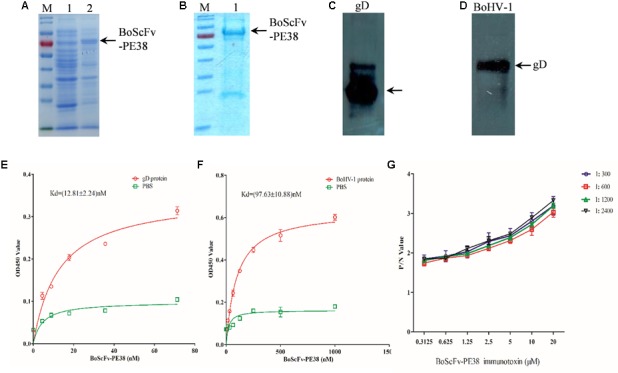
Expression and binding analysis of BoScFv-PE38. (A) Expression of BoScFv-PE38 in E. coli. M: PageRuler Prestained Protein Ladder; 1: the pET28a vector was transformed into E. coli cells, and expression was induced with IPTG; 2: the pET28a- BoScFv-PE38 vector was transformed into E. coli cells, and expression was induced with IPTG. The arrow represents the recombinant ScFv. (B) Purification of BoScFv-PE38 from E. coli via nickel affinity chromatography. M: PageRuler Prestained Protein Ladder. 1 indicates purified BoScFv-PE38, and the arrow represents purified ScFv. (C) The reaction between gD and BoScFv-PE38 was detected by western blotting. Recombinant gD protein detected by BoScFv-PE38-HRP. (D) The reaction between BoHV-1 and BoScFv-PE38 was detected by western blotting. BoHV-1: BoHV-1 was detected by BoScFv-PE38-HRP. (E) Measurement of the Kd of BoScFv-PE38 binding to the gD protein. First, 96-well plates were coated with gD (1 μg). The plates were then incubated with BoScFv-PE38-HRP and developed with TMB substrate solution. The reaction was stopped with 2 M sulfuric acid, and the optical density was read at 450 nm. The equation Y = BmaxX/(Kd + X) was used to obtain the saturation curve and the Kd of the ScFv-gD interaction using GraphPad Prism 5.0. Y represents the mean OD450 value; Bmax is the maximal OD450 value; and X is the concentration of BoScFv-PE38. (F) Measurement of the Kd of BoScFv-PE38 binding to BoHV-1. Ninety-six-well plates were coated with BoHV-1 (1 μg), and the Kd of the BoScFv-PE38-BoHV-1 interaction was measured as described above. (G) Binding affinity of BoScFvScFv-PE38 was detected using an antigen capture ELISA. Ninety-six-well microplates were coated with different concentrations of BoScFvScFv-PE38 and blocked with 3% BSA. The BoHV-1 antigen (standard serially diluted BoHV-1-positive serum; 1:300–1:2400), and HRP-conjugated goat anti-bovine IgG were added, and the plates were developed with the TMB substrate (Sigma). The reaction was stopped with 2 M sulfuric acid, and the optical density was read at 450 nm. The P/N values were analyzed using GraphPad Prism 5.0.